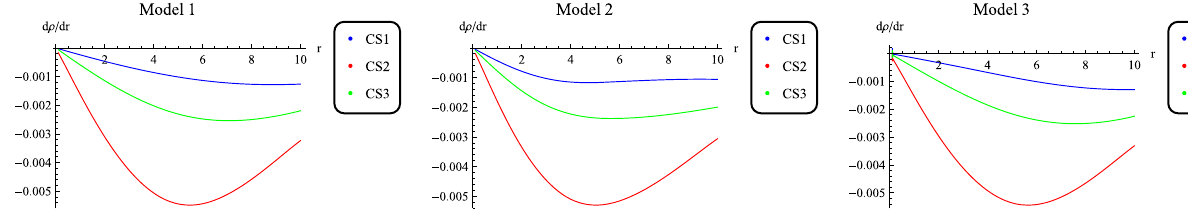
Fig. 4 Behavior of d ρ/ d r with respect to r with three different f ( R ) models